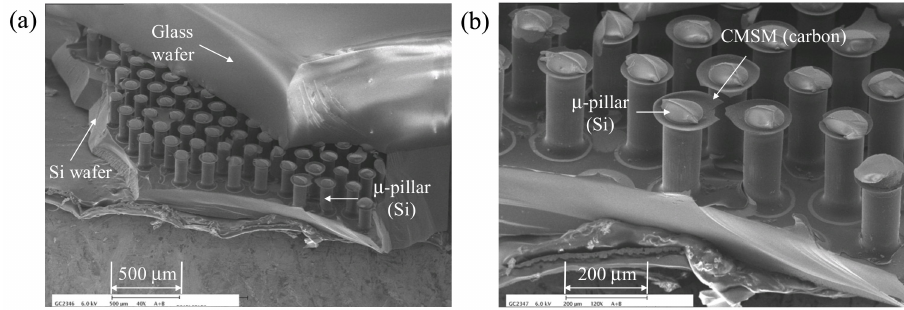
Figure 2. Scanning electron microscope (SEM) images inside the µ -preconcentrator: ( a ) 45 ◦ view angle of a crack-opened device and ( b ) magnified image to show the carbon molecular sieve membrane attached to the silicon µ